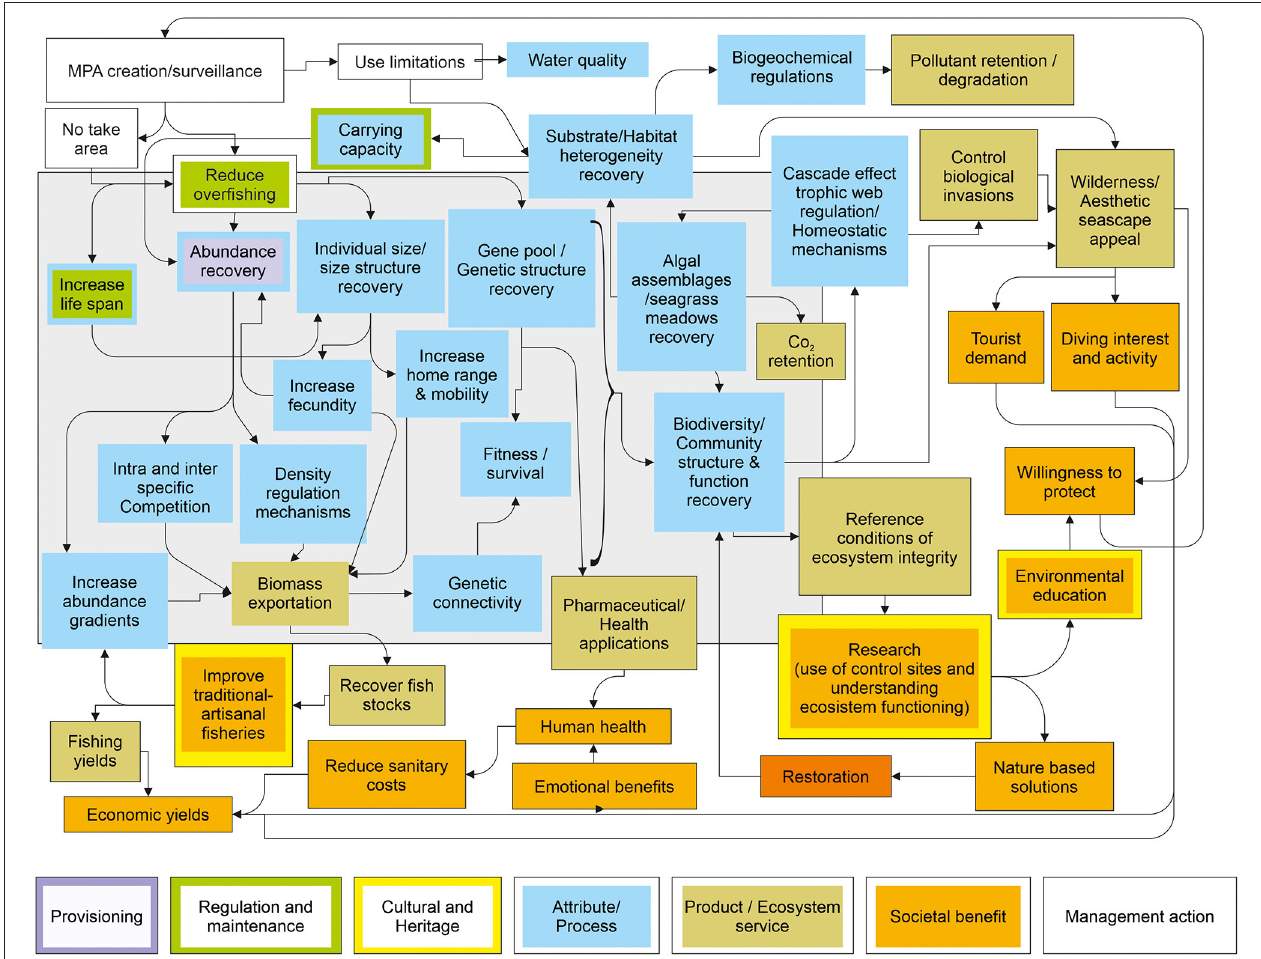
FIGURE 8 | Cause effect relationships diagram considering human actions, MPA attributes and the effects of protection on biological and ecological processes and the ecosystems services and societal benefits